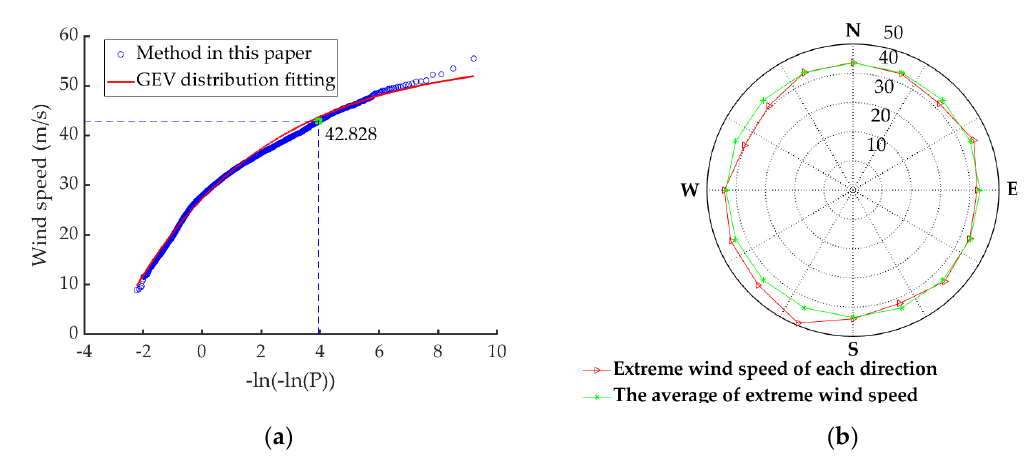
Figure 5. ( a ) Average value of EWS with 50-year recurrence period of each wind direction in Shantou Yangdong wind farm; ( b ) EWS of each wind direction in 50-year recurrence period of Shantou Yangdong wind farm. Table 3. Distribution of wind speed and direction with 50-year recurrence at 100 altitudes of six OWF. Mean Value of Wind Farm Site and Wind Farm Site EWS in and Located City